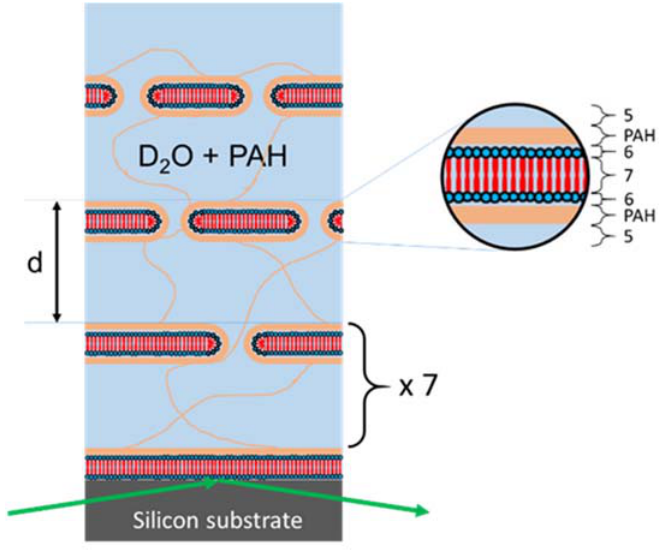
Figure 4. Model of the solid-supported oligolamellar DMPC linings against polymer solution (3 mg/mL PAH in D 2 O) applied for fitting. The neutron beam (green arrows) probes the interfacial coating through the silicon fronting. The labels in the enlargement refer to respective layer numbers in Table 1 (Table 2). PAH adlayer = layer No. 4.